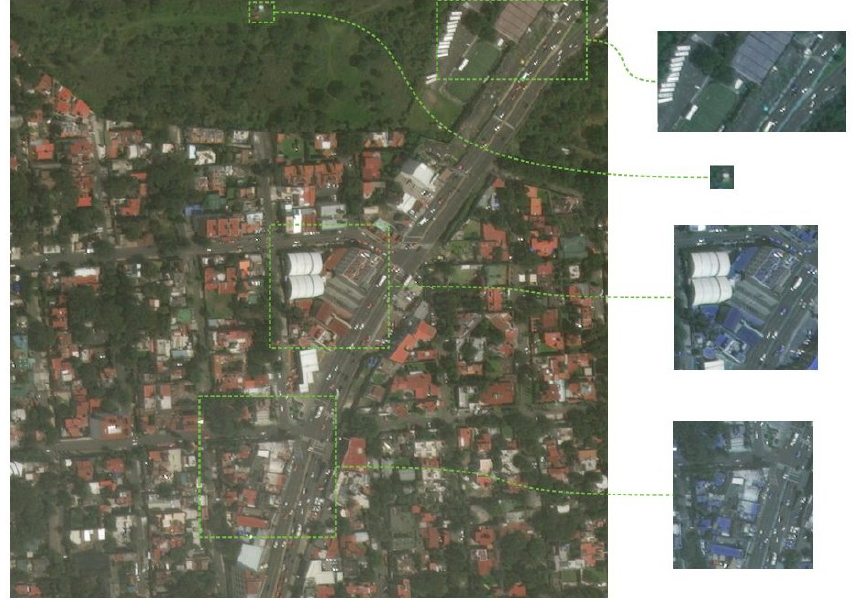
Figure 3. Isolation of labeled building instances.